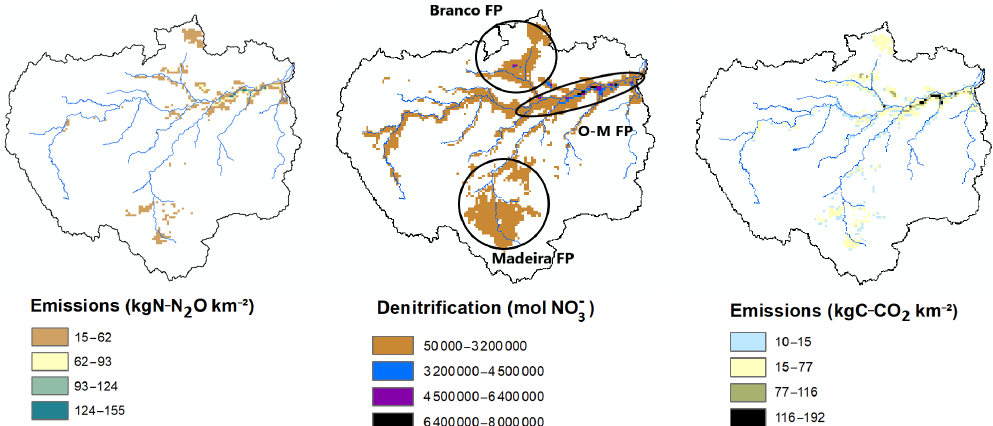
) and CO 2 emissions (kgC-CO 2 km − 2 ) 3